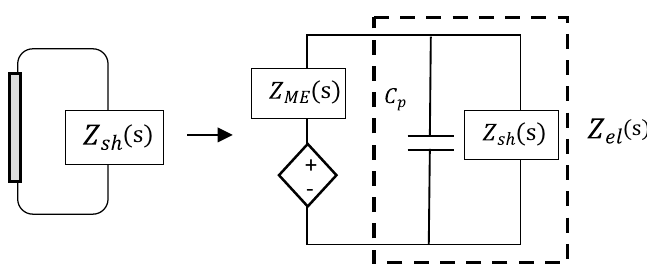
Figure 3. Physical model of a shunted PZT patch and its equivalent network